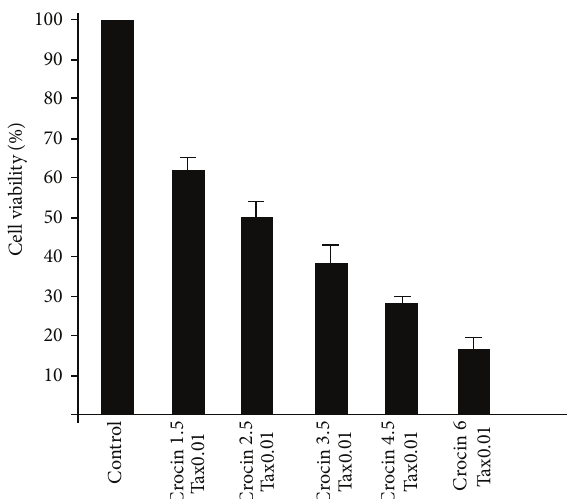
Figure 2: Survival rate of Mcf-7 cells with different concentration of crocin 2.5 mg/mL and 0.01 𝜇 m/mL of paclitaxel 48 h.